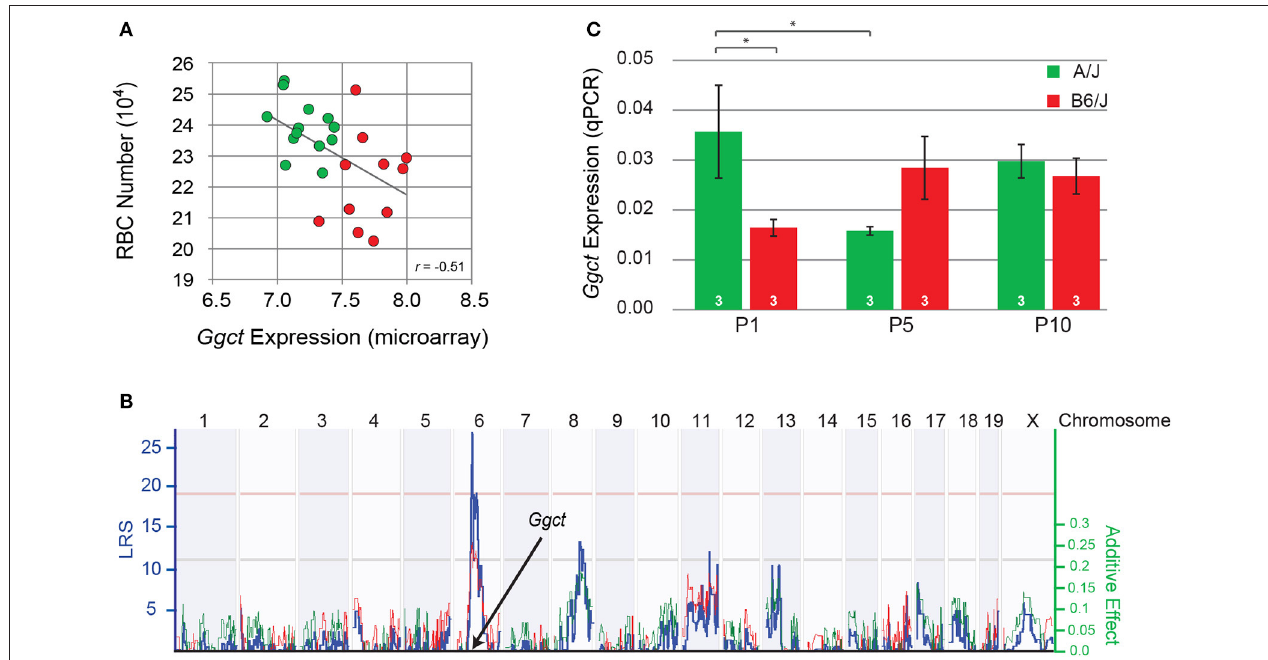
FIGURE 4 | (A) Variation in the total number of RBCs was negatively correlated with Ggct expression across the RI strain-set, derived from the AXB/BXA RI microarray expression dataset. Those strains carrying the A haplotype at the Ggct locus are indicated in green, while those carrying the B haplotype are shown in red. Each unit on the X axis indicates a doubling in expression. (B) Variation in Ggct expression mapped a significant cis -eQTL at the Ggct locus, where the presence of the B haplotype (red trace) increased expression. Conventions as in Figure 3 . (C) qPCR analysis of Ggct expression (normalized to housekeeping genes) in the parental strains during the first 10 postnatal days showed a significant interaction, indicating differential expression during the first postnatal week. * p <